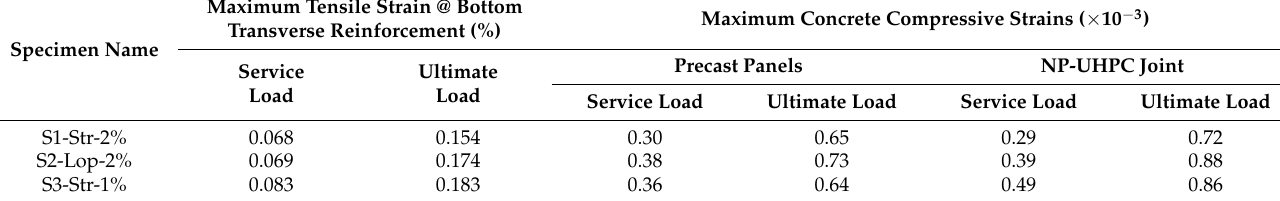
Table 6. Summary of the Maximum Tensile Reinforcement Strains and Cncrete Compressive Strains at the AASHTO LRFD Service and Ultimate